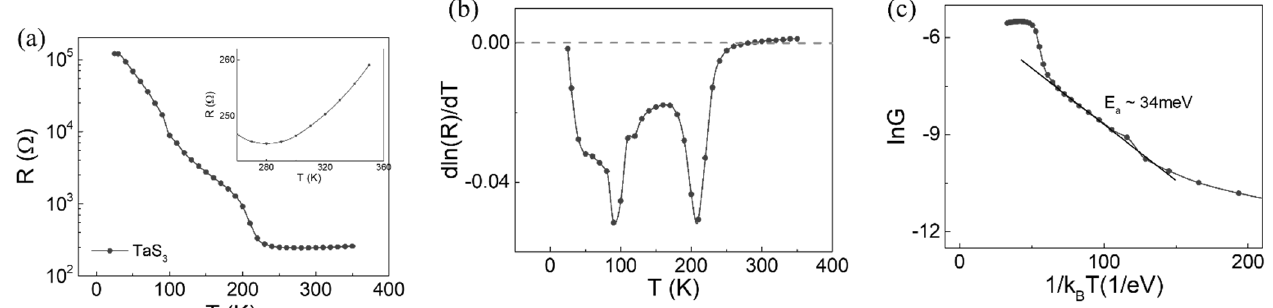
Figure 2. ( a ) Resistance–temperature curve, with an inset zoom-in chart of temperature range between 260 K and 350 K. ( b ) dln ( R ) / dT vs. T plot, ( c ) ln ( G ) vs. 1/ κ B T plot of TaS 3 measured using four-point probe method.